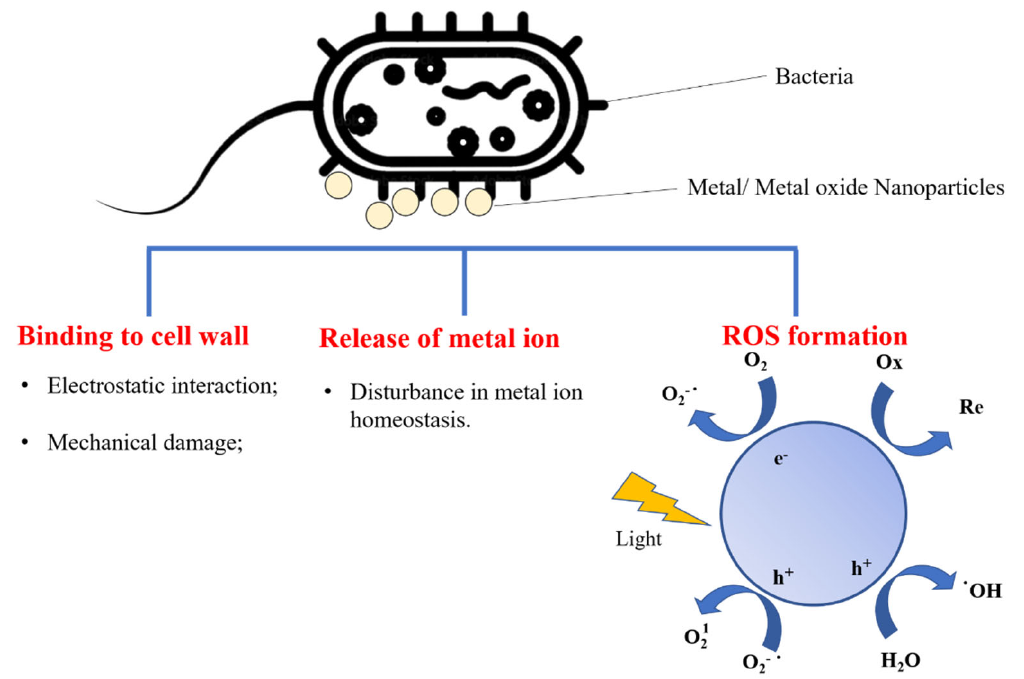
Figure 3. Molecular mechanisms of antibacterial activity of metal/metal oxide nanoparticles (ROS: reactive oxygen species).